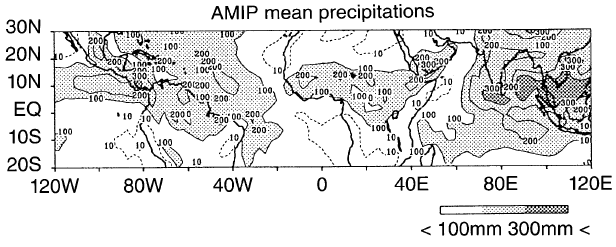
Fig. 4. AMIP 1979 — 1988 monthly mean precipitations for August. Solid lines every 100 mm per month; dashed line for the 10 mm per month level. Shaded areas : light grey for 100 — 300 mm per month, dark grey beyond 300 mm per